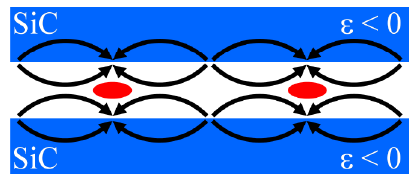
FIG. 1. Schematic of the surface wave accelerator based on SiC (SWABSiC). Acceleration occurs inside the vacuum gap between two parallel silicon carbide plates. Field lines extend from the surface of the SiC/vacuum interface into the channel and accelerate particle bunches (two bunches spaced by one acceleration wavelength are shown). Surface waves are localized near